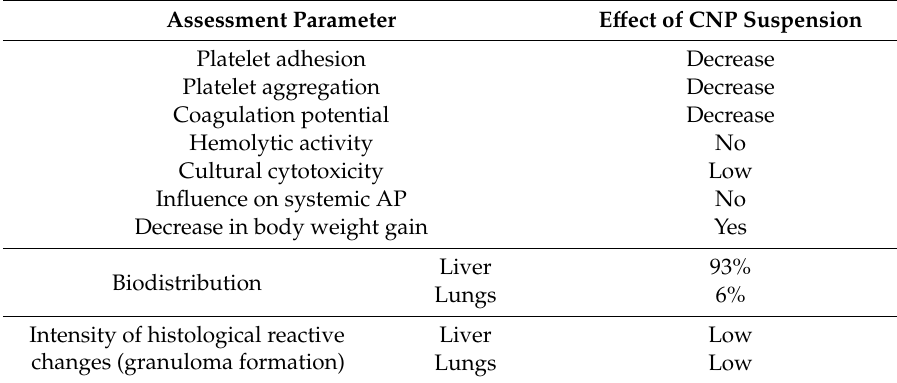
Table 3. Biological safety parameters of nanosized (100 nm)